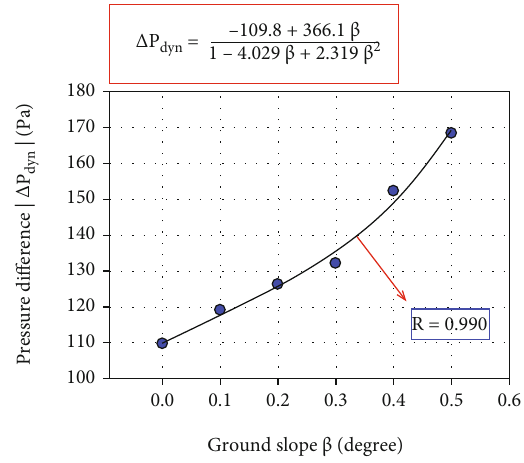
Figure 8: Dynamic pressure di ff erence across the turbine for di ff erent ground slope angles.